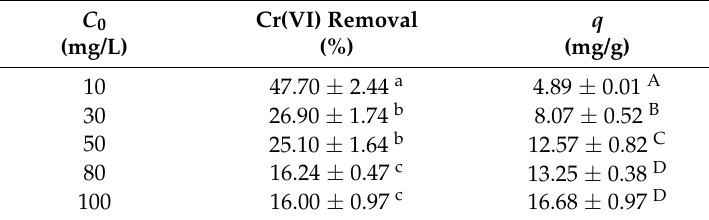
Table 1. Sorption capacity of Pseudopediastrum boryanum var. longicorne ( q ) and the percentage of chromium(VI) removal from the solution depending on its initial concentration ( C 0 ).